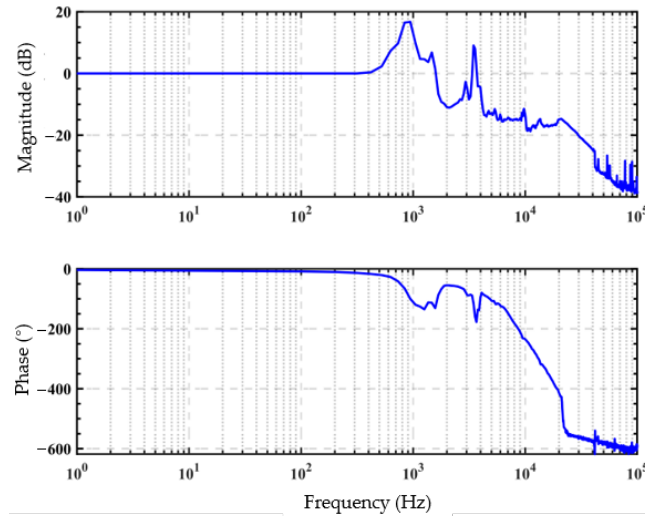
Figure 2. Experimental platform performance test.